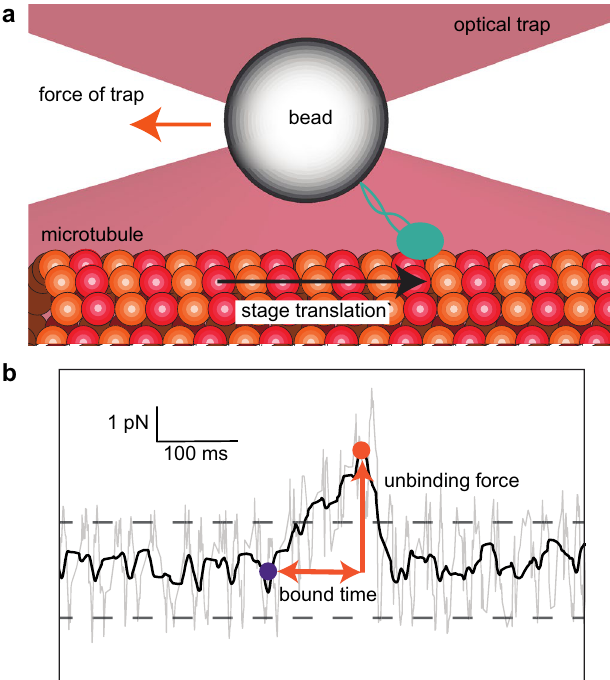
Figure 1. Microtubule-associated protein dissociation from a microtubule in a force-ramp optical trapping assay. ( a ) Schematic of a microtubule ( red and orange circles) bound to a stage that moves (with velocity, v , black arrow ) and pulls a bead conjugated to a microtubule-associated protein (MAP, green ) out of the trap center (with effective stiffness of the trap and MAP, κ ). The force that the trap exerts on the bead ( orange arrow ) increases at a rate of f = κ v (thus F ( t ) = ft ) until the MAP stochastically unbinds from the microtubule, which causes it to return to the trap center. The force-dependent unbinding rate constant, k off ( F ) , governs the biophysics of unbinding. ( b ) A typical force spectroscopy trace ( gray = raw data, black = filtered data) from a force-ramp optical tweezer assay showing the force as a function of time during a biological macromolecular binding (initial binding, purple dot ) and unbinding (final unbinding, orange dot ) event. The unbinding force and bound times ( orange arrows ) are used to determine k off ( F ) for the MAP-microtubule interaction. An event is “detected” when the filtered signal exceeds 5-times the standard deviation of the noise ( dashed lines ). This panel was graciously provided by Dr. Ashok Pabbathi under a CC BY open access